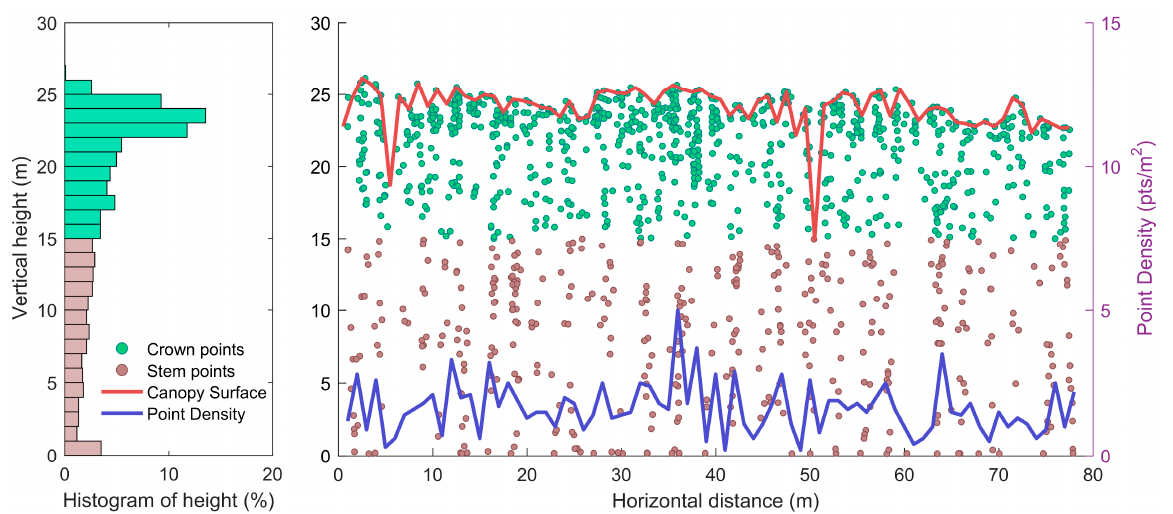
Figure 1. A profile of airborne LiDAR data representing a transect of the northern red oak stand in the study site. The red curve stands for the canopy height model (canopy surface), and the blue curve stands for the LiDAR point density